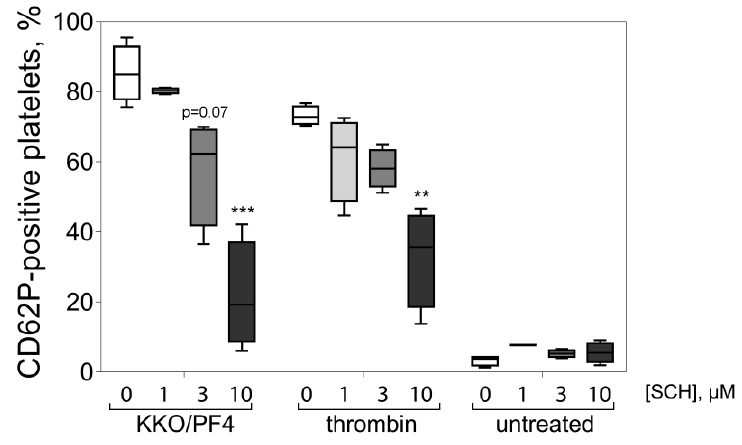
Figure 3. Inhibitory effect of SCH 79797, a selective antagonist of PAR1 receptors, on platelet activation induced by the combination of KKO and PF4. Platelets were pre-incubated for 30 min at 37 °C with SCH 79797 at 0, 1, 3, and 10 μM followed by treatment for 60 min at 37 °C with KKO/PF4 (10 and 50 µg/mL, respectively), 1 U/mL thrombin (positive control), and without any treatment (untreated, negative control). Platelet activation was assessed by the expression of P-selectin, determined using flow cytometry with fluorescently labeled anti-CD62P-Abs. Each experiment was performed with platelets isolated from three independent donors. ** p < 0.01, *** p < 0.001 compared to a corresponding control without addition of SCH 79797 (2-way ANOVA test with Dunn’s post-hoc test).